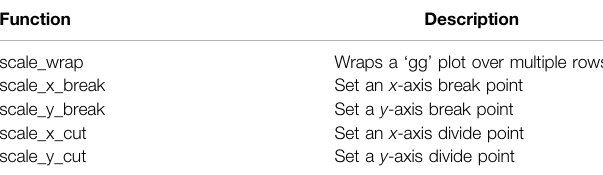
TABLE 1 | Major functions of ggbreak . Function